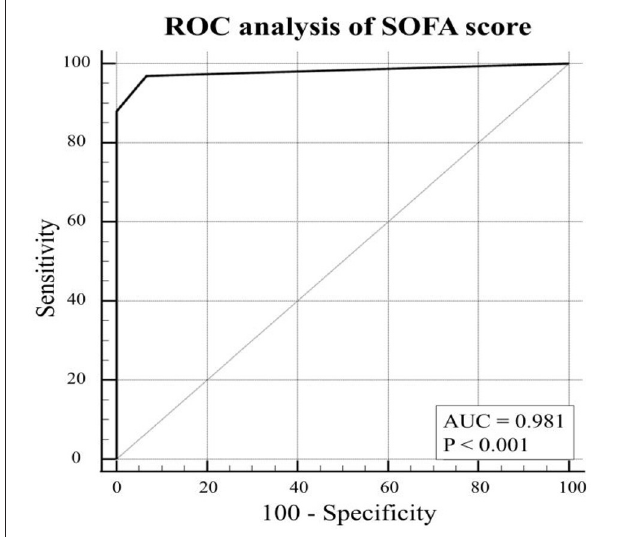
FIGURE 3 | ROC curve for SOFA score last value pre-DVT or highest value if no DVT.